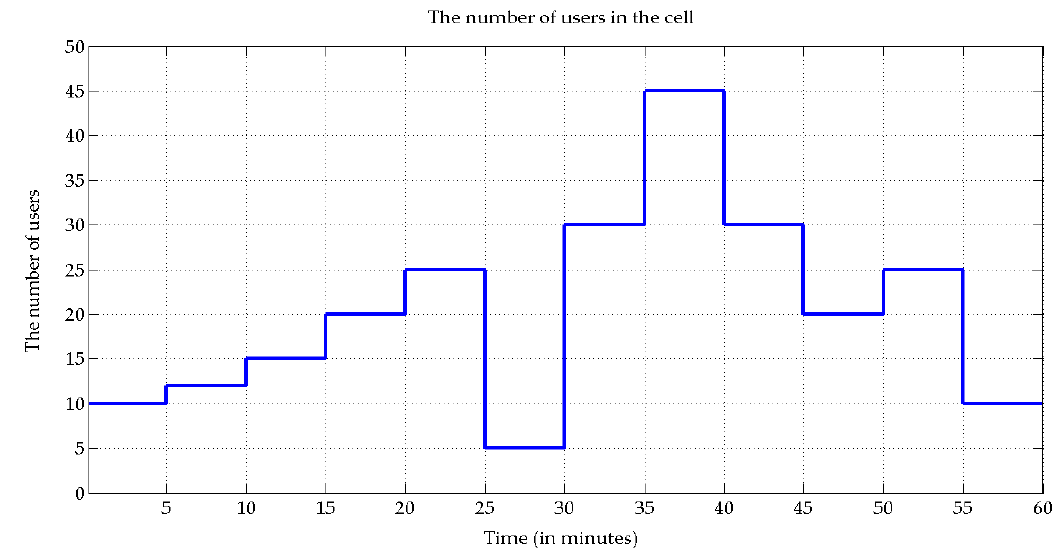
Figure 3. The number of users of the cell over time.